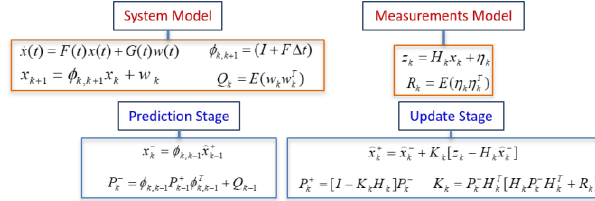
Figure 7. Modified 3D RISS navigation system scheme based Figure 9. Kalman Filter system and measurement model along on onboard sensors, CPD heading change, and vehicle with the prediction and update information.